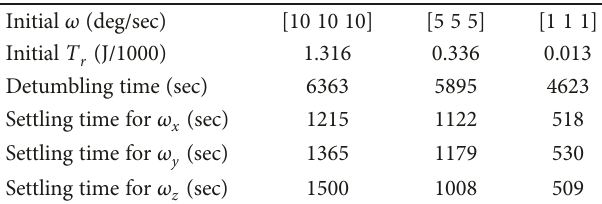
Table 3: Results from some selected test cases for h =600km and